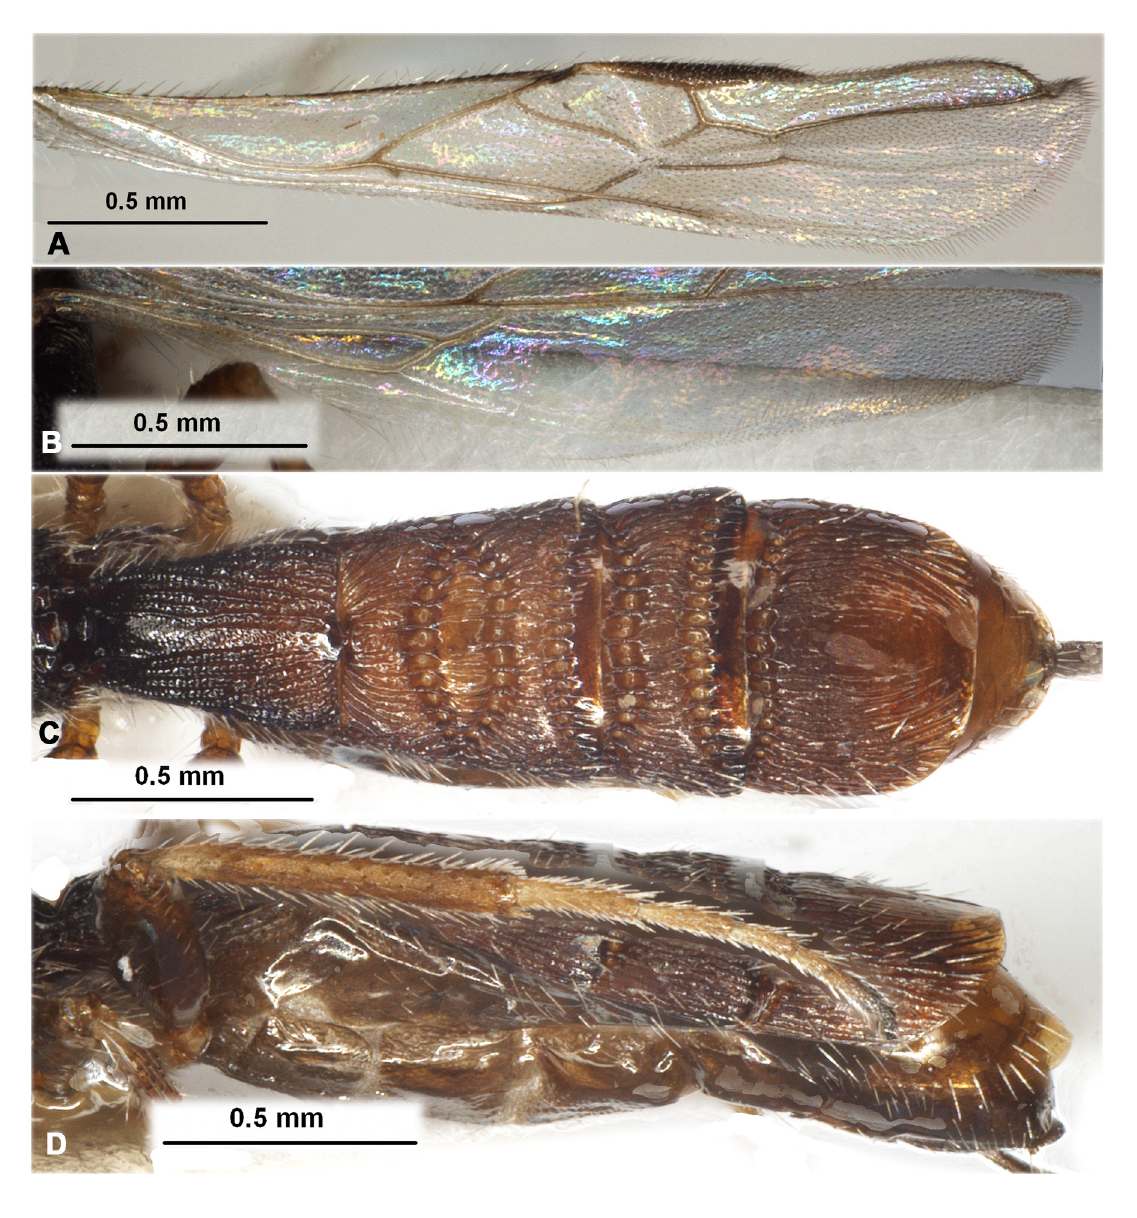
Fig. 48. Rhaconotus ( Rh. ) arabicus Belokobylskij, 2001, ♀ (RMNH). A . Fore wing. B . Hind wing. C . Metasoma, dorsal view. D . Metasoma, lateral